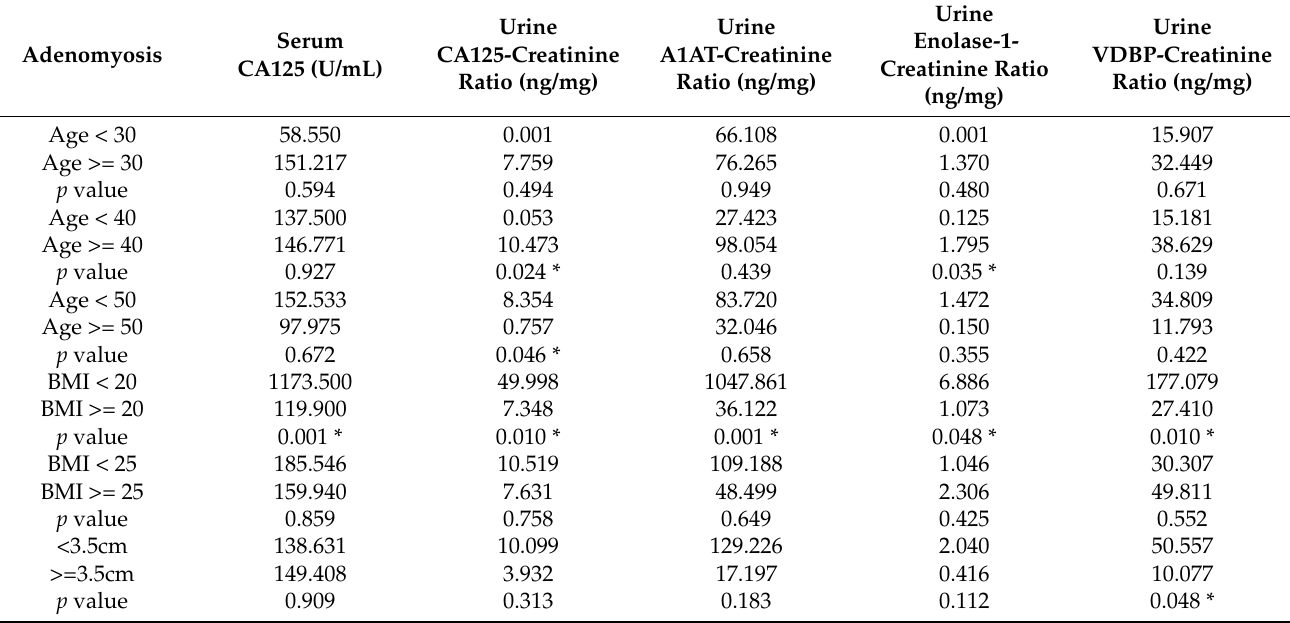
Table A4. The median values comparison of examined biomarkers in different subgroup analysis of parameters in patients with uterine adenomyosis.